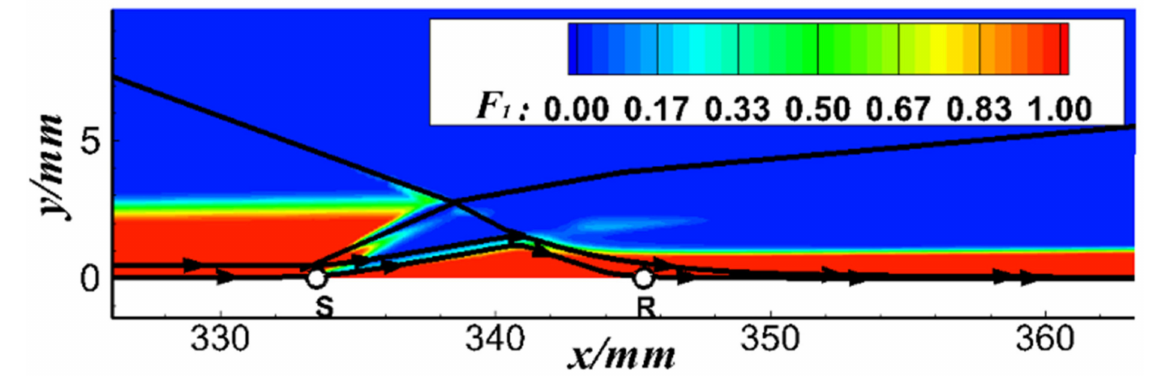
Figure 16. F 1 contour of the results in the standard SST